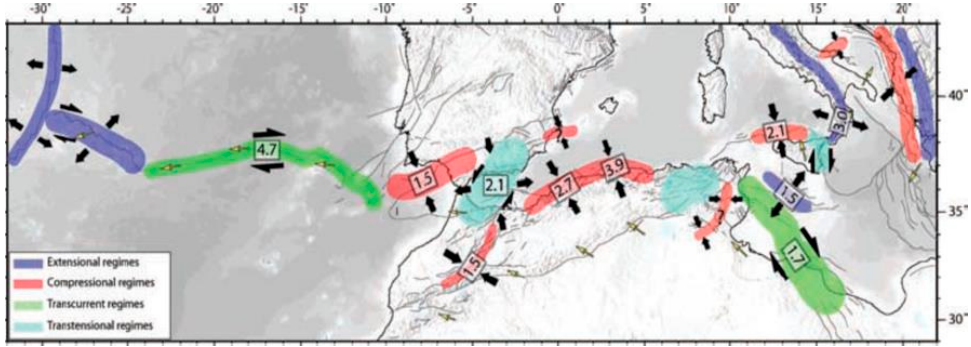
Figure 3. Main tectonic and kinematic regimes in the African–Eurasian plate boundaries.